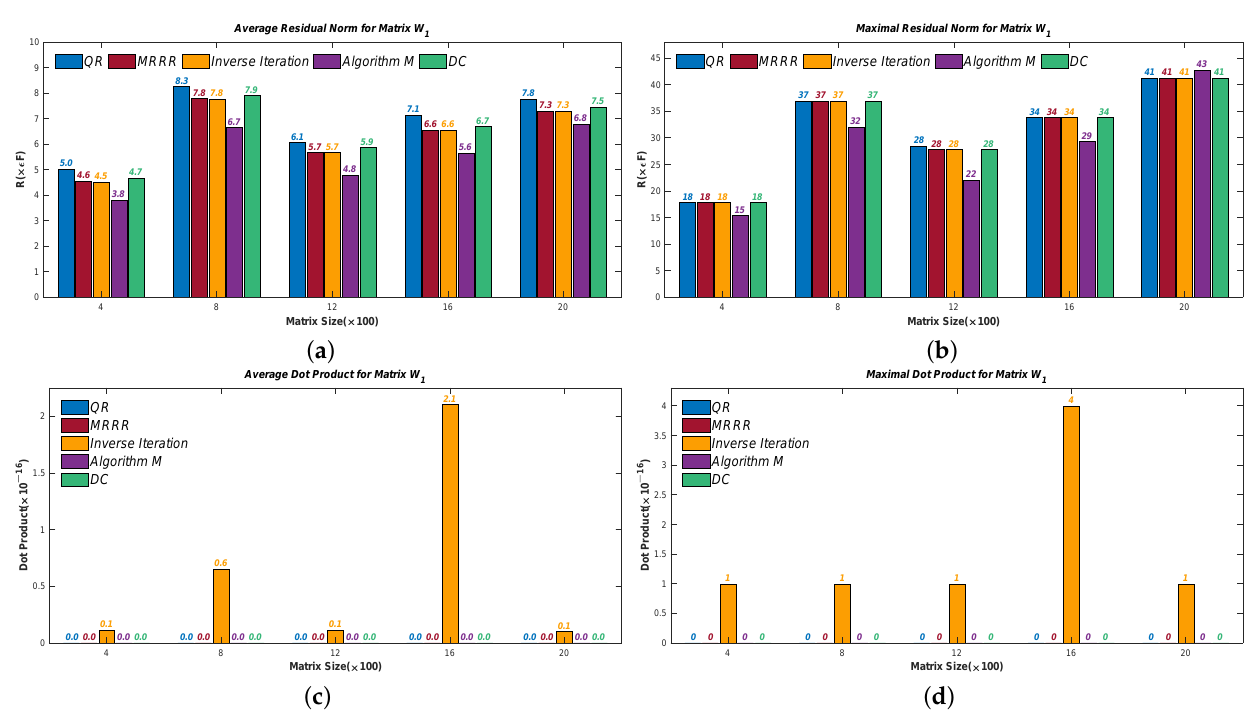
Figure 7. The accuracy results of Matrix W 1 : ( a ) the average residual norm; ( b ) the maximal residual norm; ( c ) the average dot product; ( d ) the maximal dot